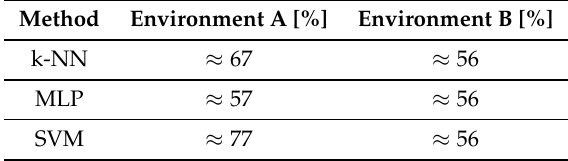
Table 3. Percentage of testing points lower than minimum half-distance between beacons.